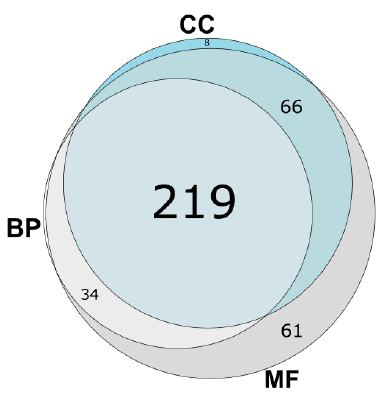
Figure 6. Venn diagram showing distribution of predicted uPE1 protein functions among GO (BP—biological process; MF—molecular function; CC—cellular component) .